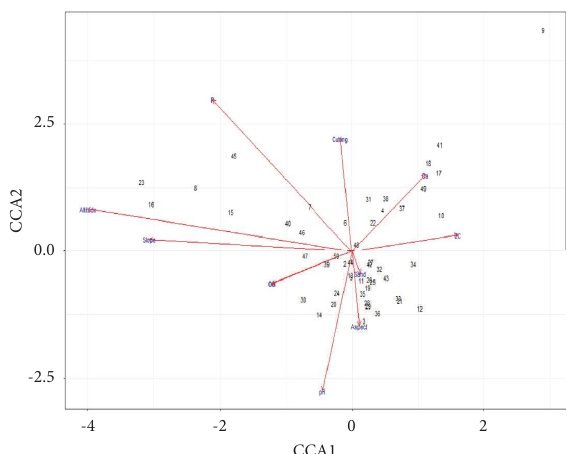
Figure 12: Impacts of environmental variables on vegetation CEC = cation exchange